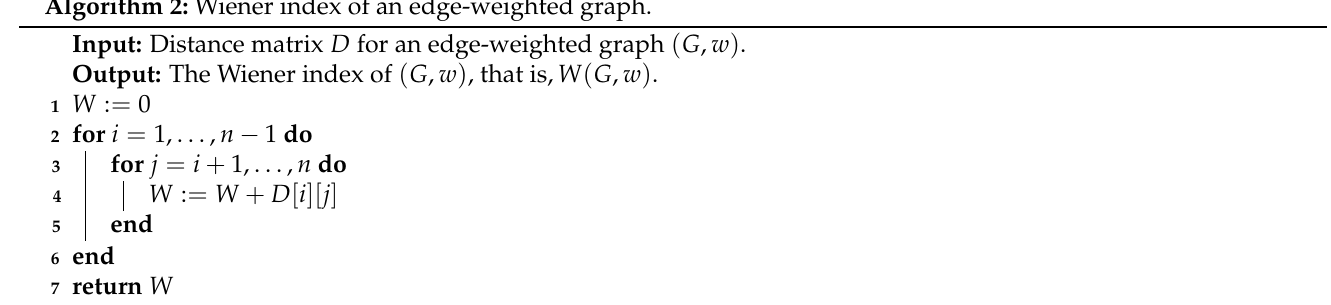
Algorithm 2: Wiener index of an edge-weighted